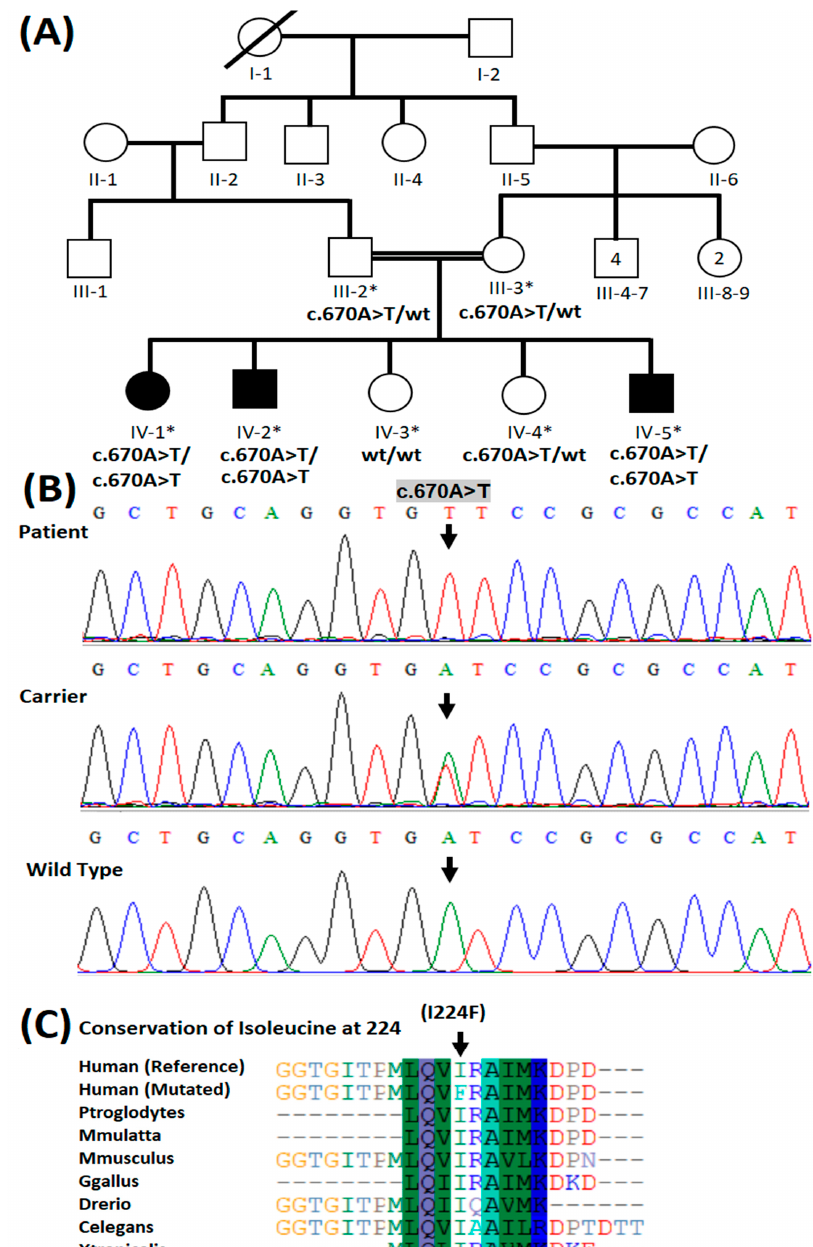
Figure 1. ( A ) Four-generation pedigree of a family showing consanguinity and autosomal recessive mode of inheritance of the disease. Squares represent males while females are denoted by circles. In this family pedigree, filled squares and circles indicate the presence of methemoglobinemia in male and female, and white squares and circles represent healthy males and females, respectively. The asterisk symbol above individuals represents those who participated in the study. Genotypes have been shown beneath each individual participating in the present study. ( B ) Partial sequence of exon 8 of CYB5R3 showing variant c.670A > T in homozygous form in patients, heterozygous form in carriers, and wild type in healthy control individuals. An arrow indicates the site of a variant in the patient. ( C ) Conservation of isoleucine at amino acid position 224 in CYB5R3 protein in species with a known CYB5R3